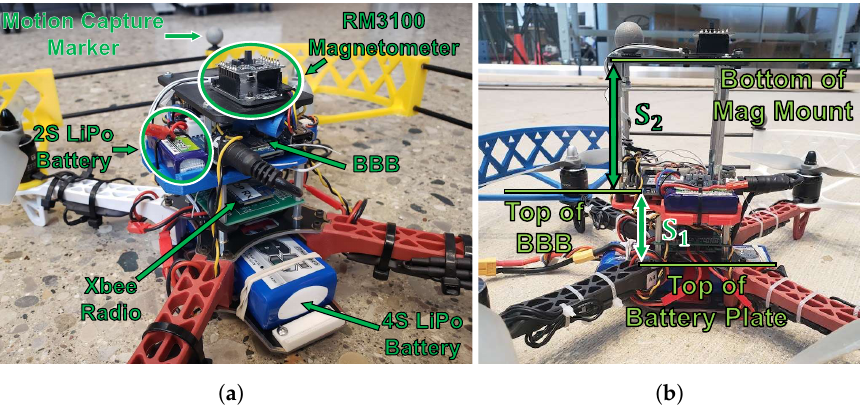
Figure 3. Q1: The flight vehicle used for experiments in this work. ( a ) Main components of Q1. S 2 = 2 cm. ( b ) Definition of S 1 and S 2 . S 2 = 8